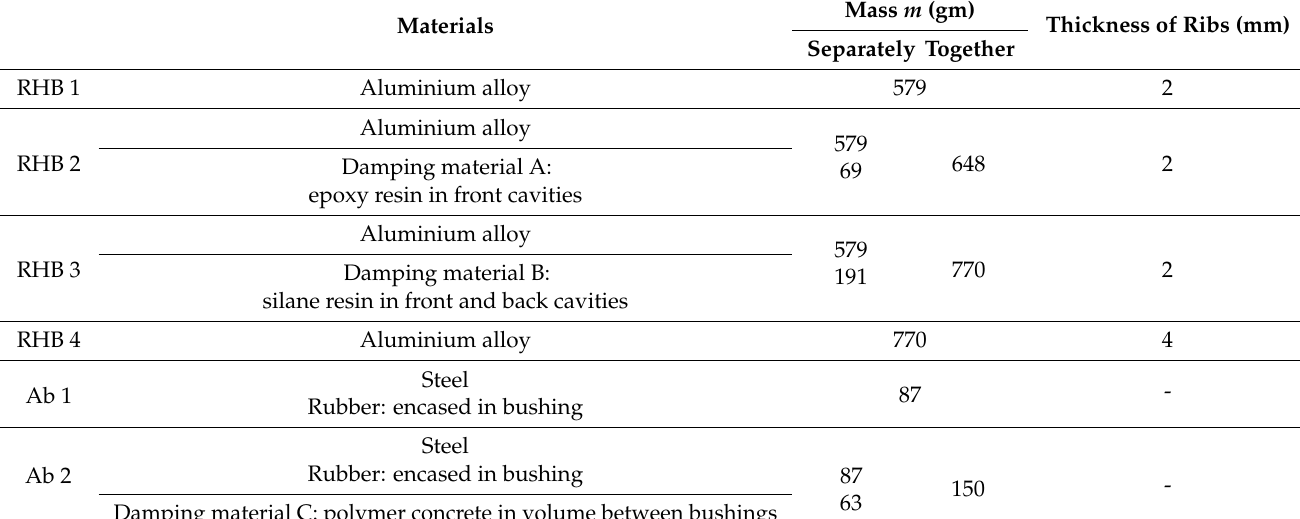
Table 1. Materials and design properties.